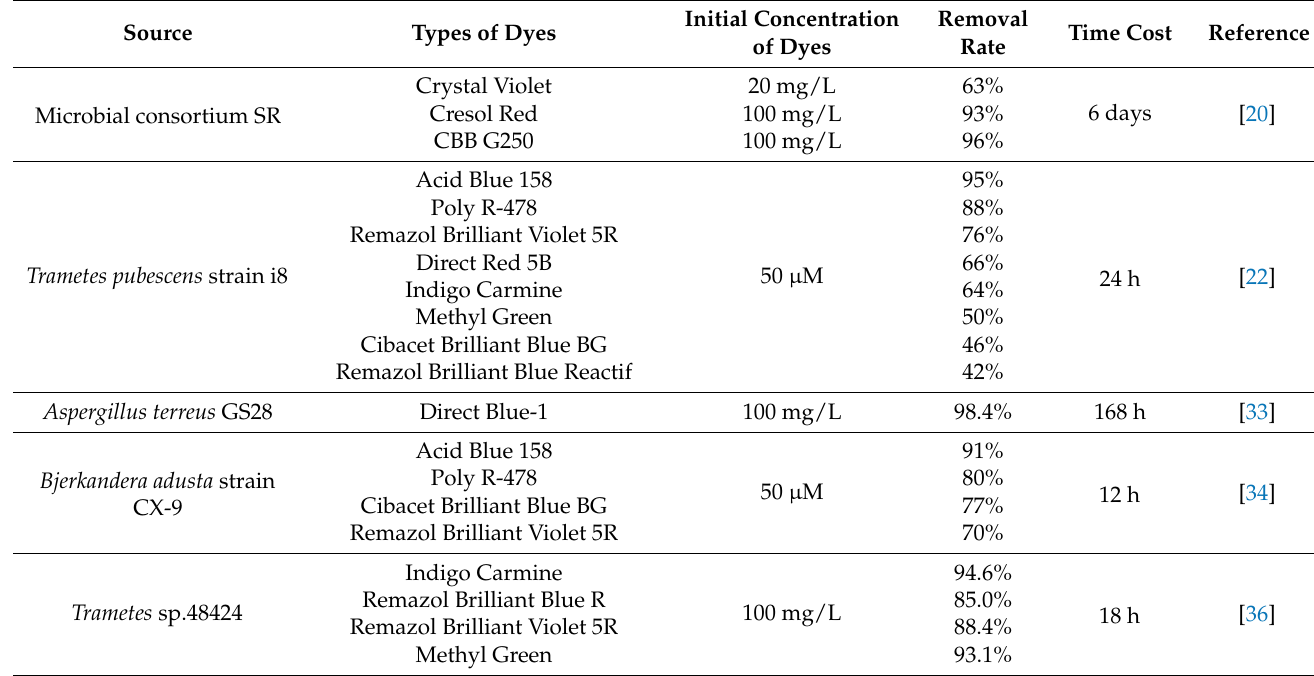
Table 1. Recent applications of unmodified MnPs in dye